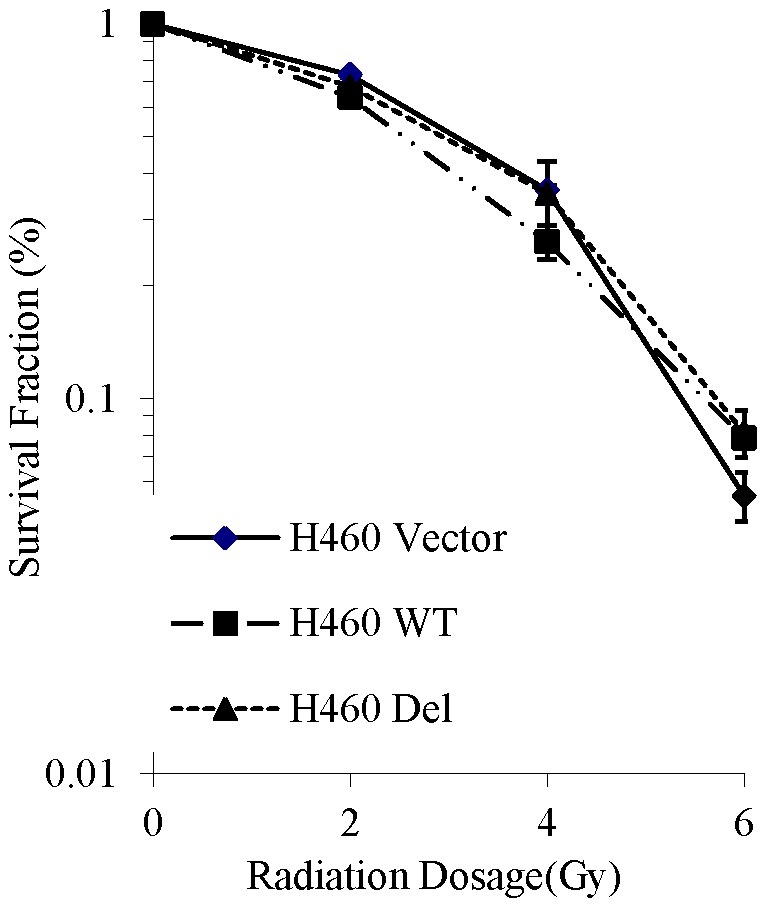
Overexpression of novel p53 mutation does not confer radiation resistance.p53 variant does not affect radiation resistance in the presence of WT p53. Transfection with WT p53 results in slightly decreased survival after irradiation with 4: (SF = 0.2); WT: 1.05 (p = 0.074); DEL: 0.97 (p = 0.27).